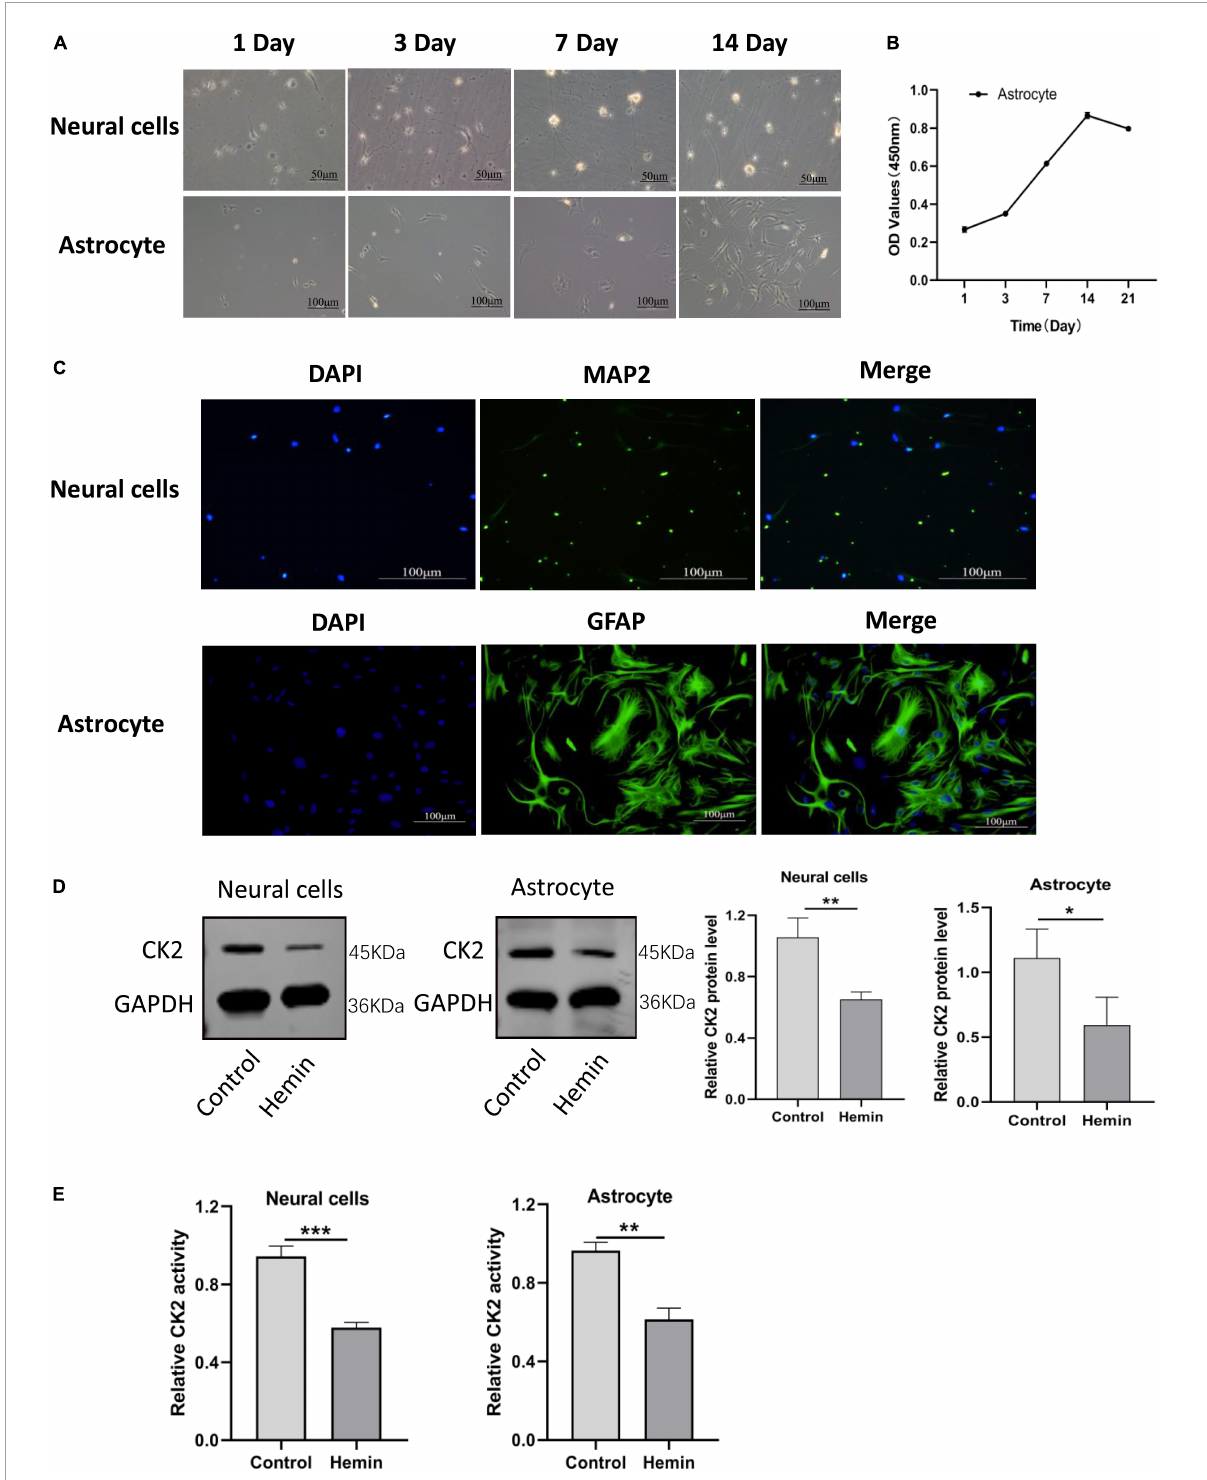
FIGURE4 CK2 activity and expression levels were decreased in cultured neurons and astrocytes treated by hemin. (A) Morphological changes in neurons and astrocytes were observed. (B) Proliferation ability of astrocytes was detected using CCK8 assay. (C) Neurons and astrocytes were identified using immunofluorescence. (D) Hemin treatment decreased CK2 protein expressions levels in cultured neurons and astrocytes. (E) Hemin treatment decreased enzyme activity of CK2 in cultured neurons and astrocytes. The cell experiment was repeated three times independently. Data were expressed as mean ± SD. * p < 0.05, ** p < 0.01, *** P <